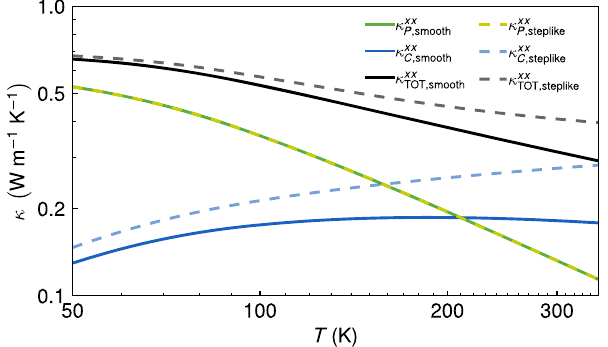
FIG. 13. Effect of the phase convention on the thermal conductivity of CsPbBr 3 . Solid lines are the conductivities computed using the correct size-consistent smooth phase con- vention, dashed lines are the conductivities computed using the size-inconsistent steplike phase convention (also reported in Fig. 1 of Ref. [37]). The populations ’ conductivities are green ( κ xx P ), and they are equal in the two phase conventions (see text). The coherences ’ conductivities ( κ xx C ) are blue. The total conduc- κ xx κ xx tivity (black) is given by the sum κ xx P þ C . Using the tot ¼ steplike phase convention yields a total conductivity larger than that obtained using the smooth phase